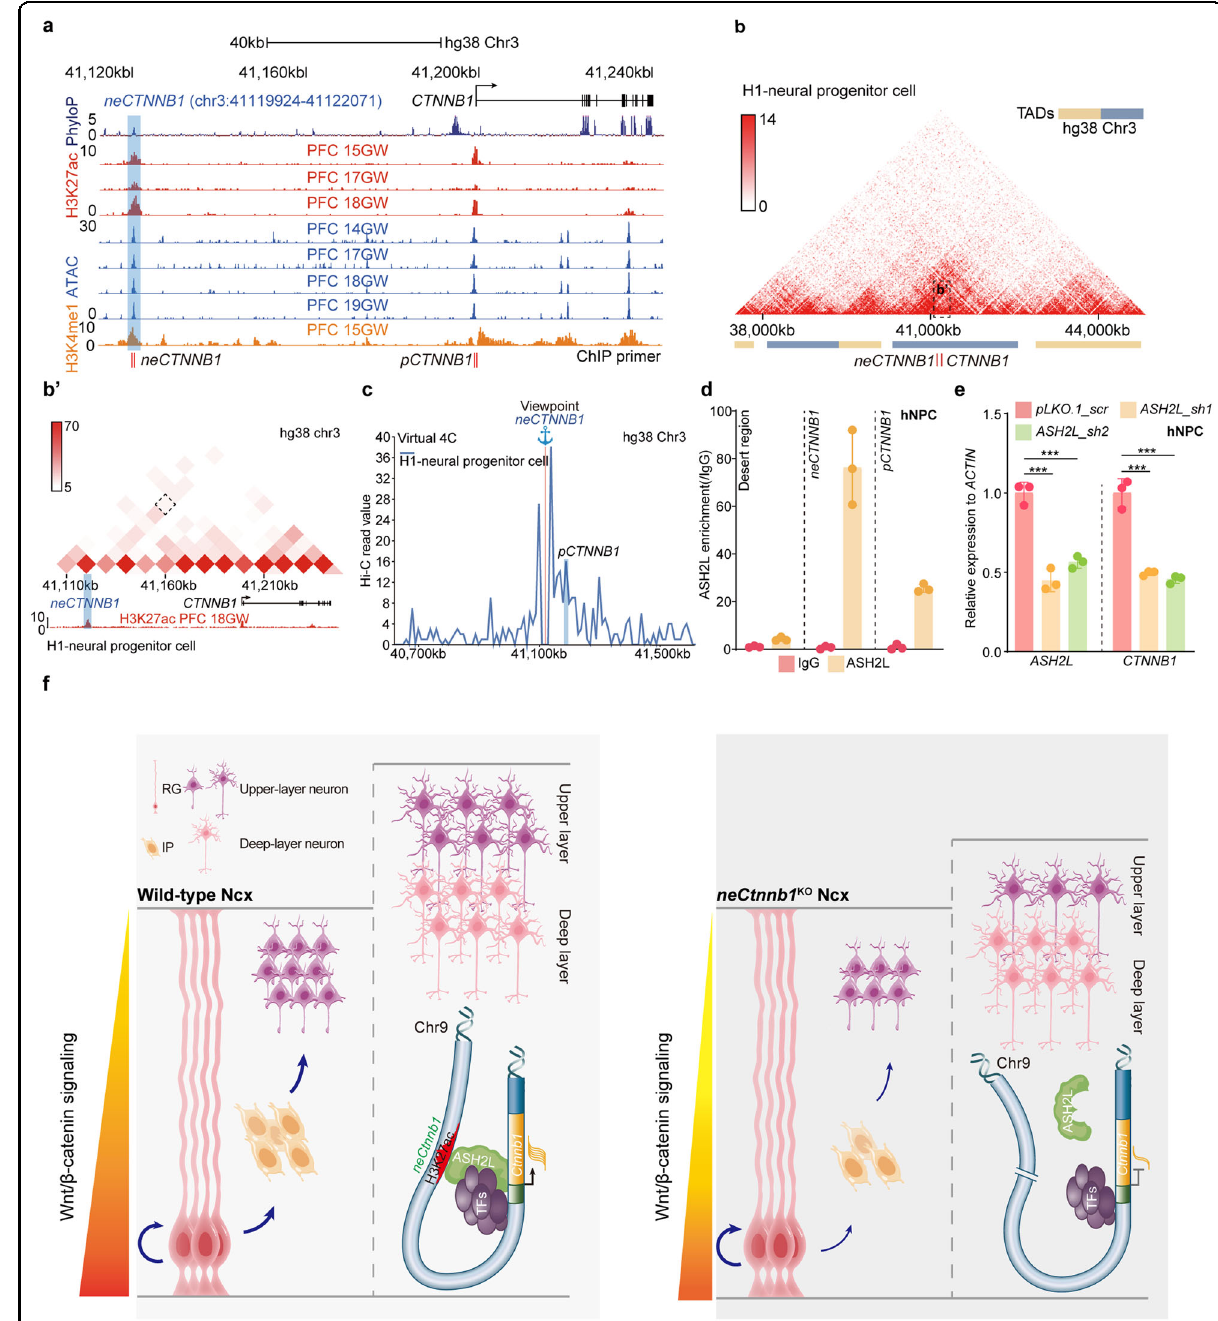
Fig. 6 neCTNNB1 is the human CTNNB1 enhancer. a Schematic representation of human CTNNB1 gene and the location of putative neCTNNB1 enhancer (blue shading) marked by H3K27ac and H3K4me1 peaks and ATAC signals. b Hi-C data of H1-derived human neural progenitor cells (hNPC) were obtained from the 3D genome browser. Boundaries of TADs and locations of neCTNNB1 and CTNNB1 (red bars) are indicated below. b ' Regions magni fi ed from ( b ). neCTNNB1 interacts with CTNNB1 in H1-derived hNPC. c Virtual 4C of H1-derived hNPCs revealing interactions between neCTNNB1 with pCTNNB1 . d ChIP-qPCR of hNPC using an anti-ASH2L antibody. e RNA levels of ASH2L (left) and CTNNB1 (right) in hNPC transfected with indicated virus for two days. Each point represents an independent experiment ( d , e ). f The working model. neCtnnb1 , the upstream enhancer of Ctnnb1 , controls production and transit-ampli fi cation of IPs, hence proper productions of UL PNs. ASH2L associates with neCtnnb1 and positively regulates transcription of Ctnnb1 in the neCtnnb1 -dependent manner. In e , quanti fi cation data are shown as means ± SD. statistical signi fi cance was determined using two-way ANOVA followed by Sidak ’ s multiple comparisons test ( e ) * P < 0.05, ** P < 0.01, and *** P < 0.001. ns not signi fi cant. PFC dorsal lateral prefrontal